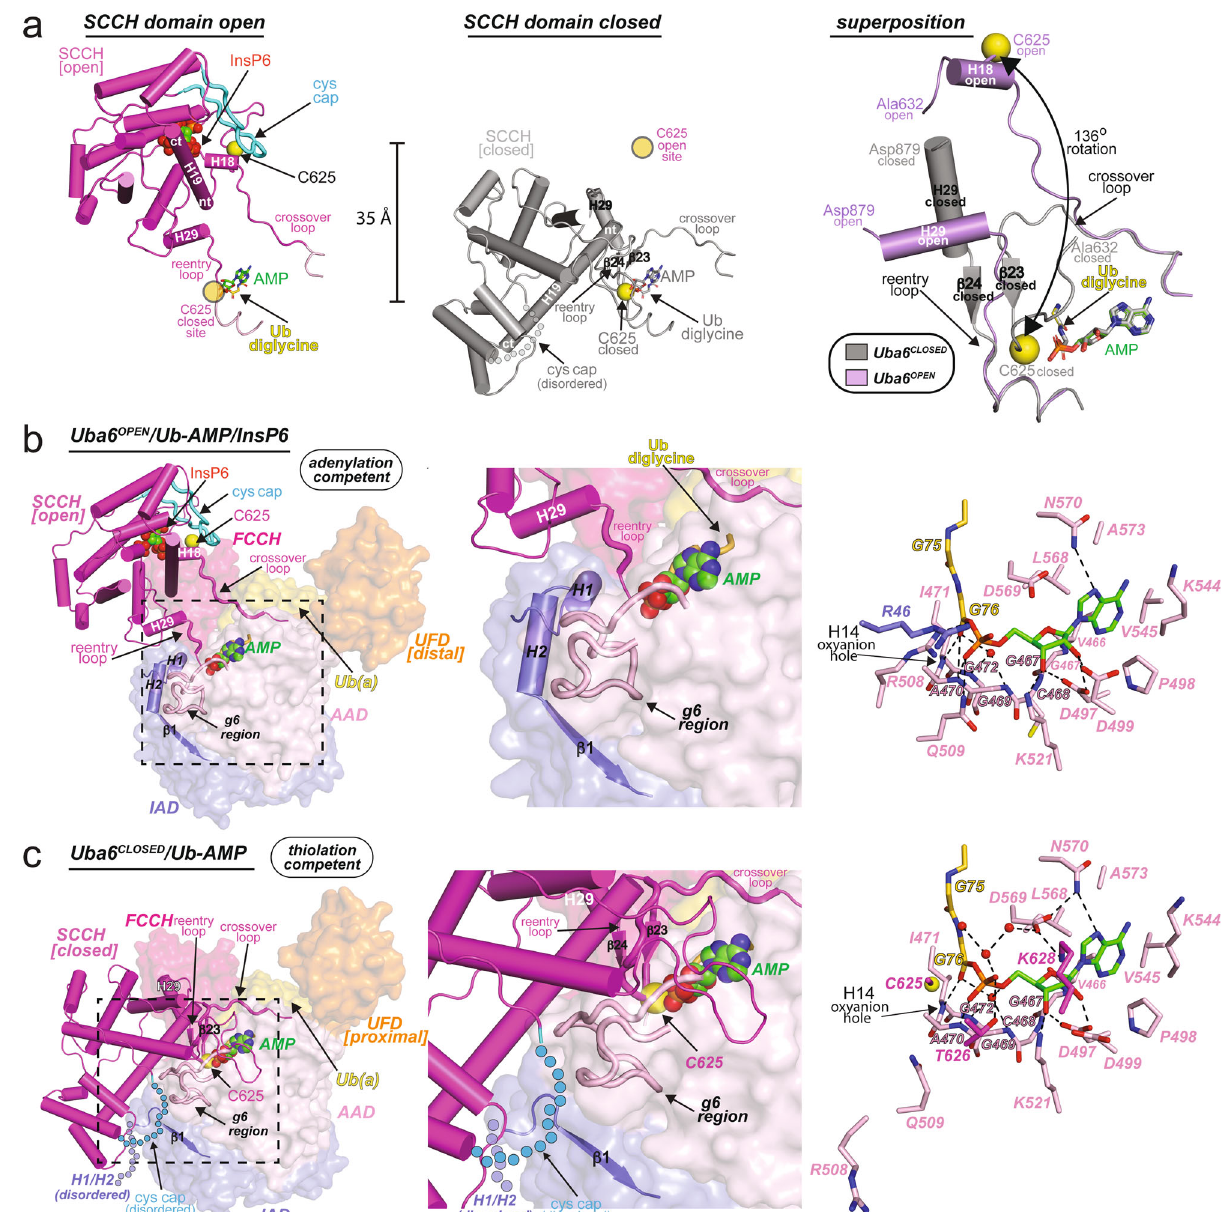
Fig. 2 | Structural changes in Uba6 accompany transitions from adenylate to thiolation-competent states. a Comparison of Uba6 SCCH domain in the open (adenylation active) and closed (thioester bond formation active) conformations. The adenylation domains (which serve as the rigid body of Uba6) were super- imposed and theSCCH domains are shown ascartoons withthe catalyticcysteines shown as spheres. The degree of rotation between each SCCH domain conforma- tionalstateisindicated.Toprovideaframeofreference,therelativepositionofthe catalyticcysteineintheotherSCCHdomainconformationalstatesisindicatedwith semitransparent yellow circles and labeled accordingly in each of the panels.